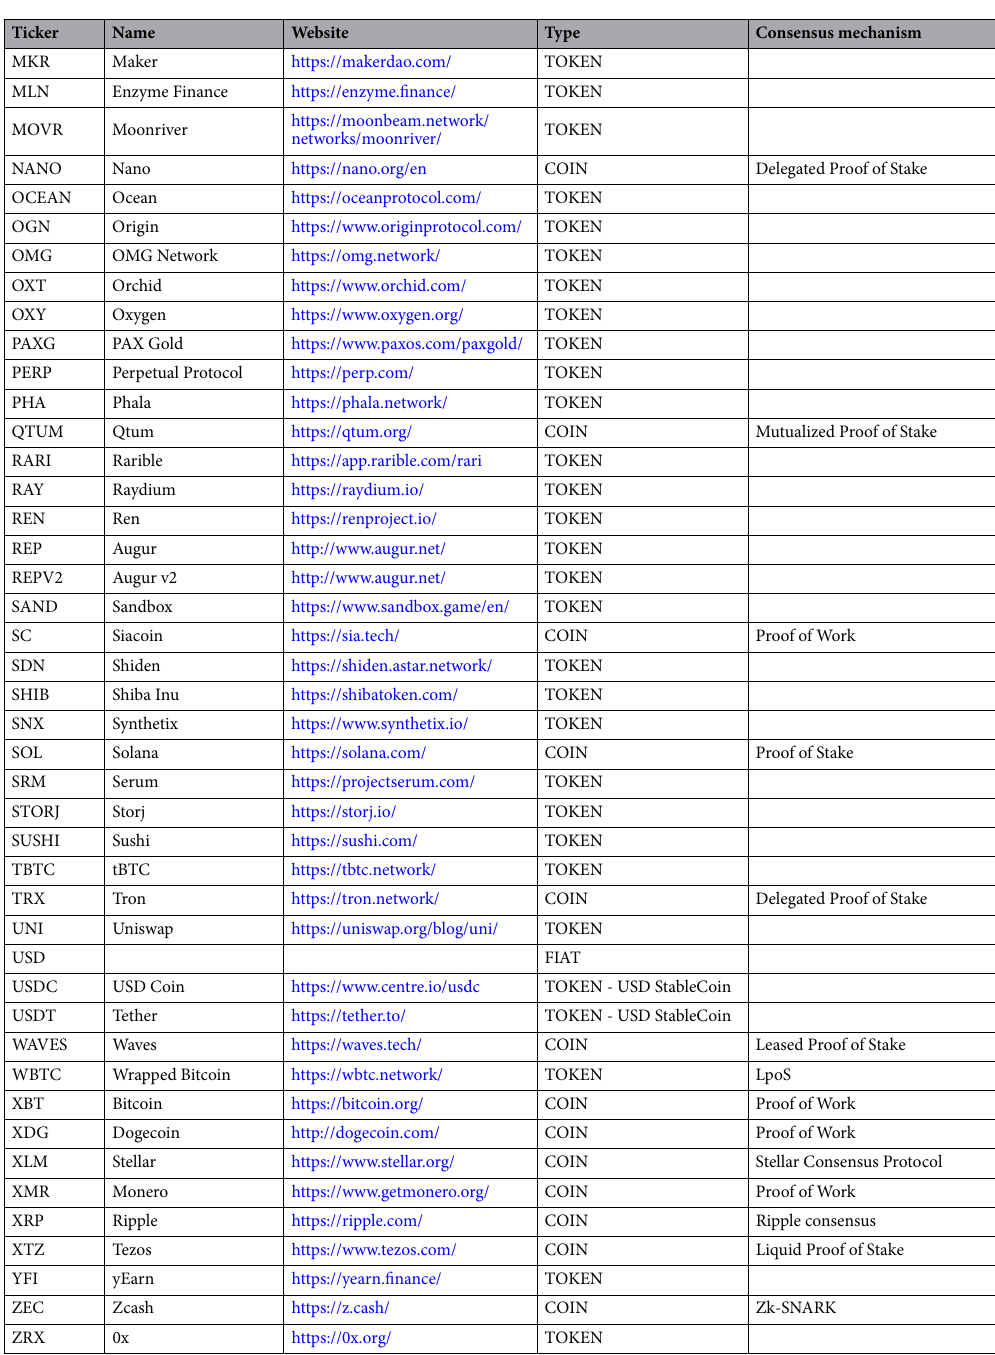
Table 3. Tickers description. Each row provides some information on the ticker, such as the name of the coin, the website of the project, its type (COIN for cryptocoin which hold their own blockchain, TOKEN for cryptos built on top of another cryptocoin, fiat for currencies and TOKEN - USD Stablecoin for token hooked to the USD dollar price) and what algorithm it is used as consensus mechanism (for COINS